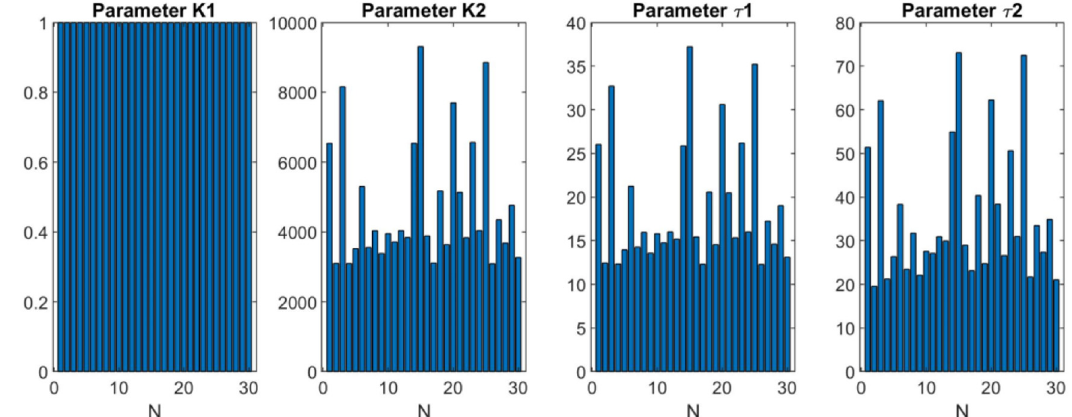
Fig. 6. Individually (using one dataset at a time) estimated model parameters of equation